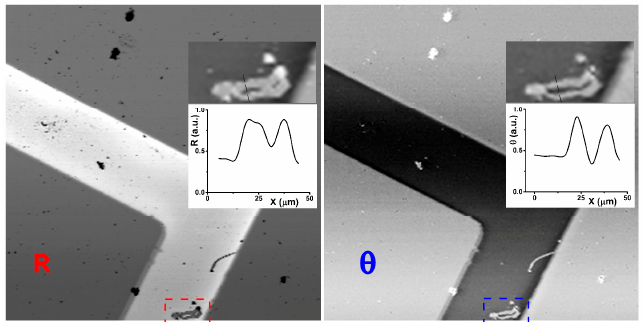
Figure 2. On the left, the hyperspectral reflectance confocal microscope (HSCM) image of a Au/Ti structure on a Si substrate is seen in a standard reflectance mode, shown for 600 nm wavelength. On the right, the correspondent phase image after the KK elaboration, selected for the same wavelength, shows rather clearer details, as it is clear looking to the defect marked (bottom) and visible magnified in the insert together with a detailed cross-section, for both images respectively. The reflectivity image part has been copied inverted to better compare with the phase image.